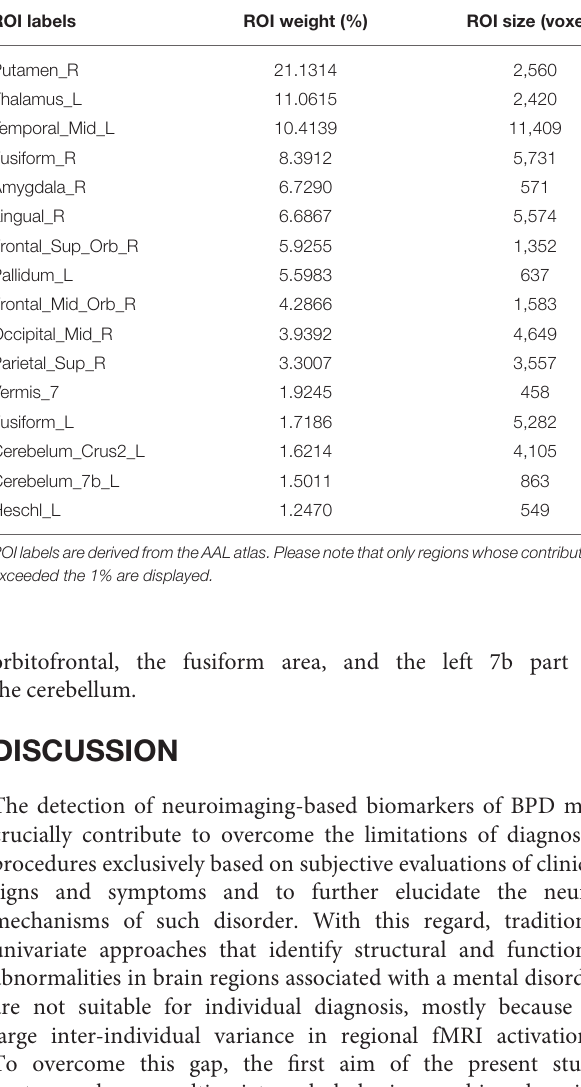
TABLE 2 | Main regions derived from the classification of BPD against controls.